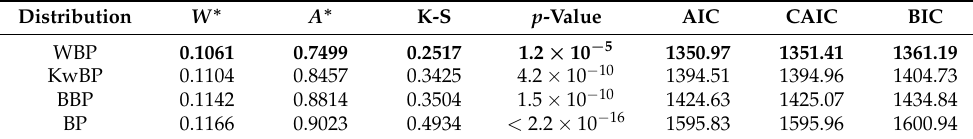
Table 4. Adequacy measures for COVID-19 data in US.